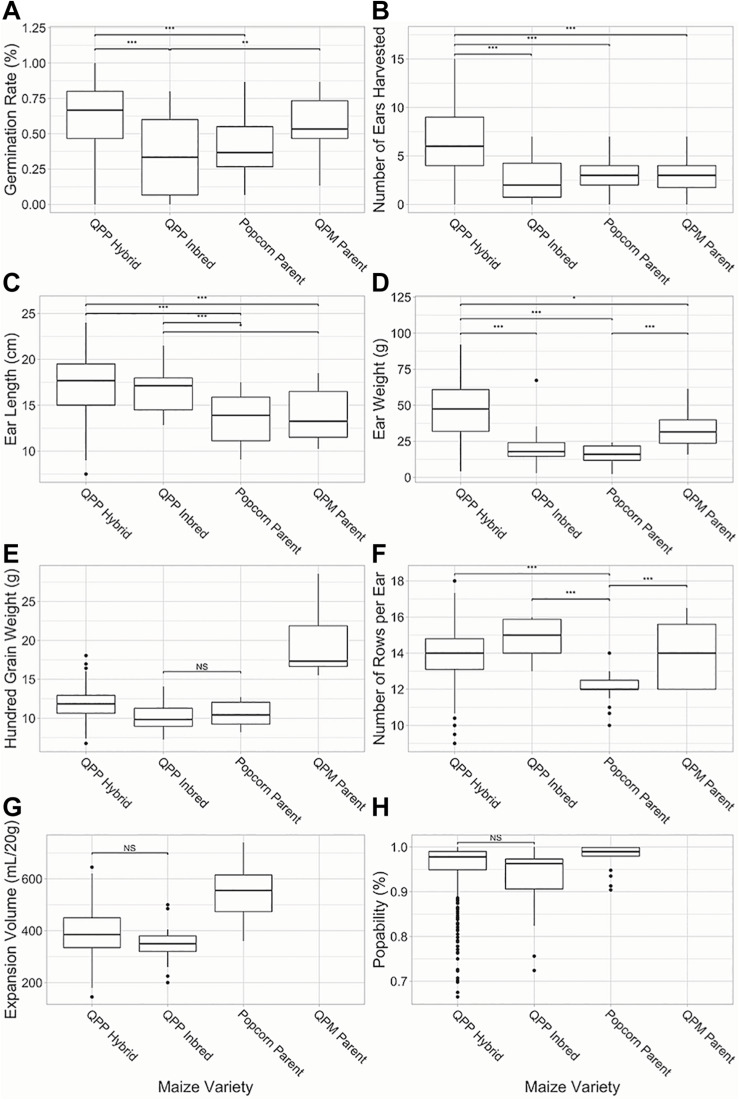
Comparison of QPP hybrids and inbreds in agronomic and popcorn quality traits. Six agronomic and two popcorn quality traits were compared between QPP hybrids and QPP, popcorn, and QPM inbreds. (A) Germination rate, (B) Number of ears harvested from single rows, (C) Ear lengths, (D) Ear weight, (E) Hundred grain weight, (F) Number of kernel rows per ear, (G) Expansion volume, and (H) Popability were compared. Popping traits were not available for QPM dent inbreds. Significant differences were noted at the p < 0.001, 0.001, and 0.01 levels as “***,”“**,” and “*,” respectively. “NS” denoted non-significant comparisons between groups if all other comparisons were significant. Whisker length signify range of values, boxes signify upper and lower quartiles, and the horizontal line denotes average value.